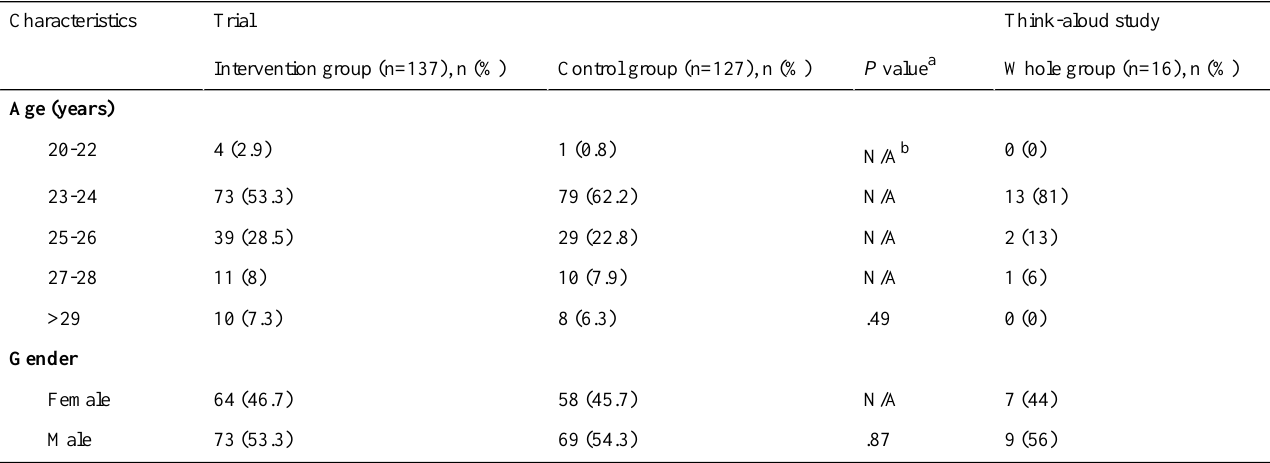
Table 1. Participant characteristics at baseline in the trial and think-aloud study.